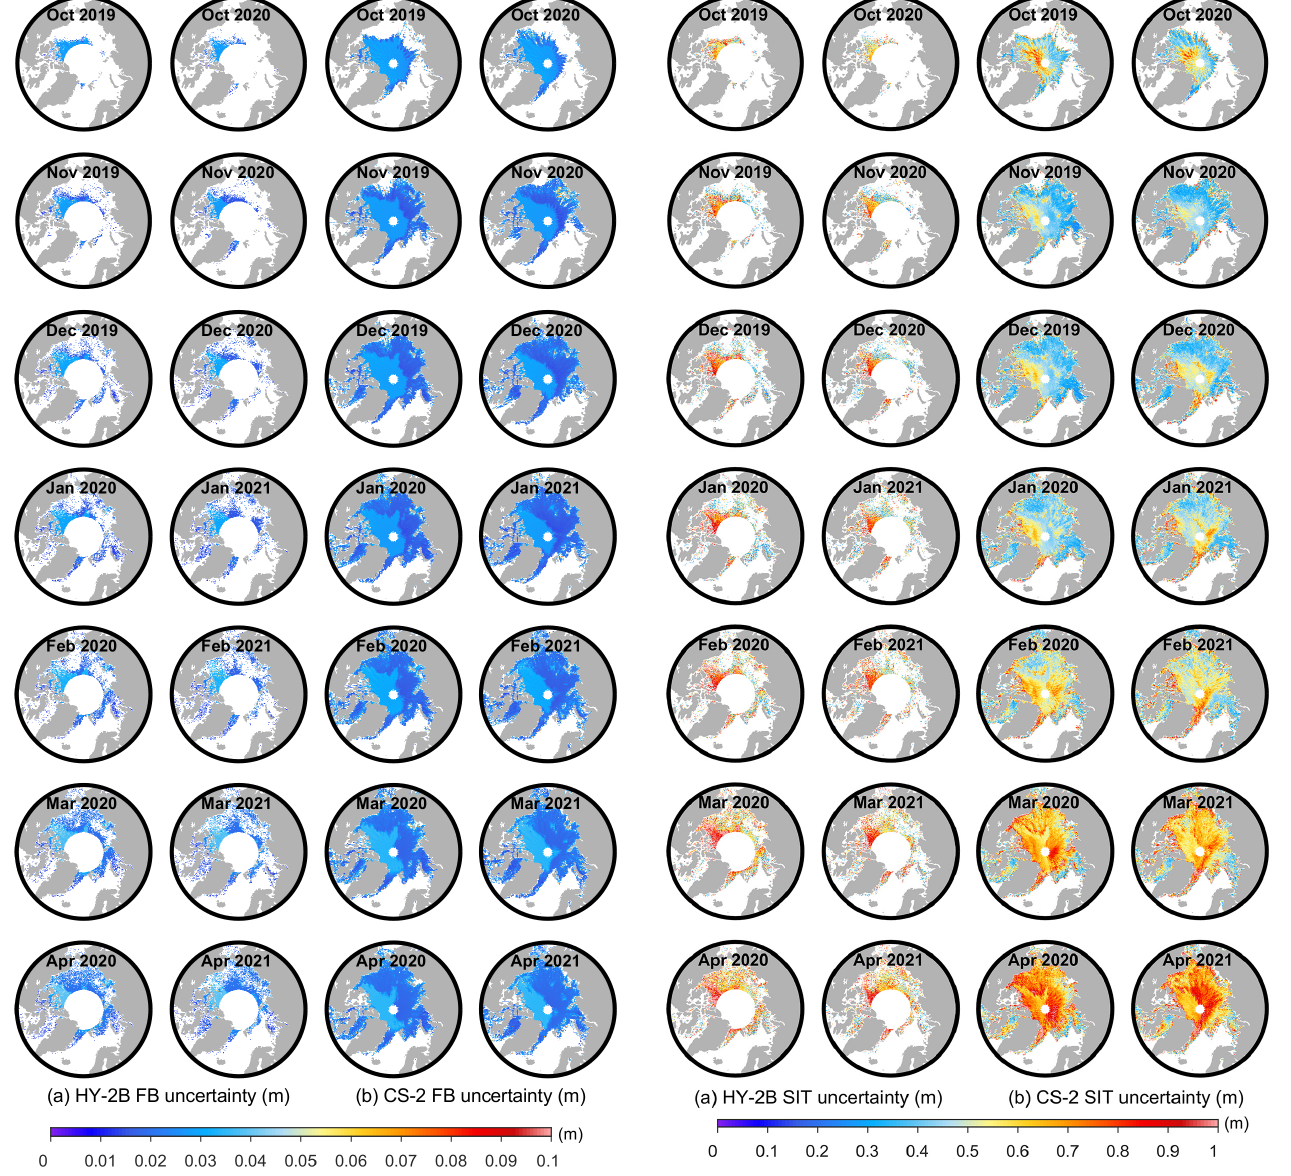
Figure 11. Monthly comparisons between HY-2B sea ice freeboard uncertainties and CS-2 sea ice freeboard uncertainties from Octo- (a) shows the HY-2B sea ice freeboard uncertainties, and panel (b) shows the CS-2 sea ice freeboard uncertainties.